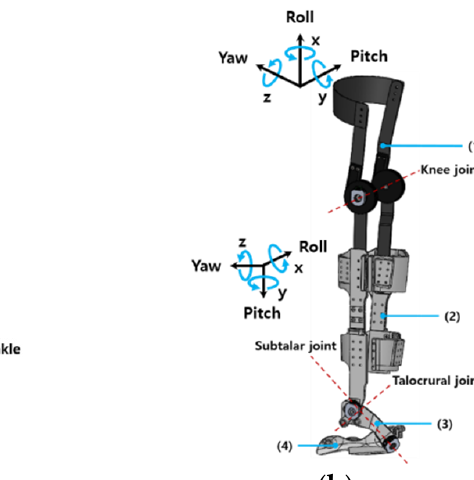
( a ) ( b ) Figure 1. Structure of the developed exoskeleton robot: ( a ) Inertial measurement unit (IMU), force-sensitive resistors, absolute encoder, and force-sensitive resistors amplifier. ( b ) 3D-modeled lower limb exoskeleton robot, inertial measurement unit, axis of Inertial meas-urement units (IMU), knee, and ankle joint position. (1) Knee orthosis (thigh), (2) frame for tibia (shank), (3) frame for talus, (4) frames for calcaneus. Table 1. Mass analysis of the manufactured exoskeleton robot.